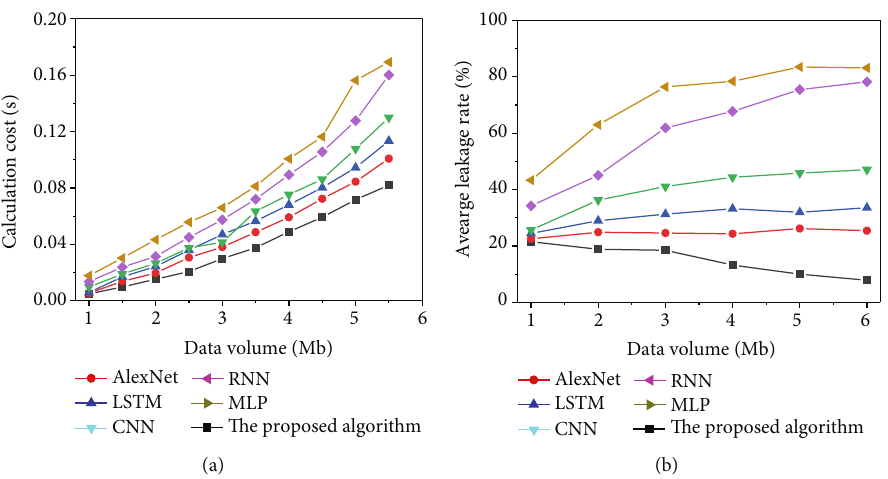
Figure 9: The in fl uence curve of calculation consumption and average leakage rate with the increase of the amount of data under di ff erent algorithms ((a) calculation consumption; (b) average leakage